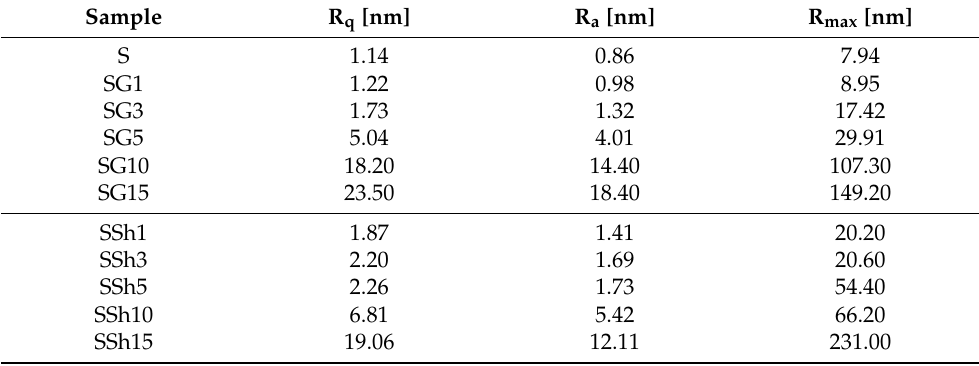
Figure 9. AFM images of pure Sylgard and its composites containing shungite. In the case of samples containing up to 5 wt.% of graphite as well as shungite, no significant changes in the R a and R q parameters have been observed. The data in Table 2 indicate that the values of average surface roughness (R a ) and root mean square surface roughness (R q ) range from about 1 to 5 nm. The increase in quantity of both fillers (10 and 15 wt.%) leads to a huge increase in values of all analyzed roughness parameters: R a , R q , and R max . Table 2. Roughness parameters of pure Sylgard and Sylgard-based composites containing carbonaceous fillers.